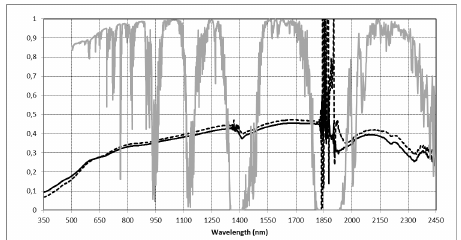
Figure 4. Bare soil spectral signatures measured in-situ for the two areas with marked metal signature (in black). Atmospheric transmission (in grey): spectral bands related to low transmission cannot be processed.